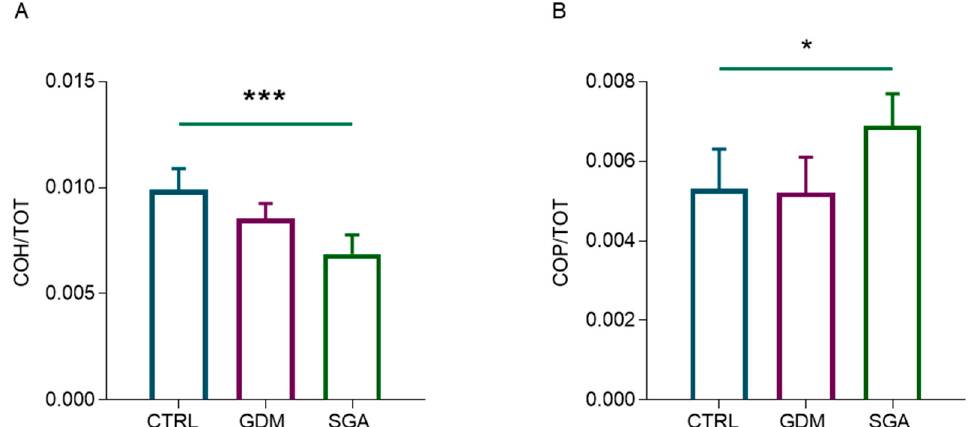
Figure 9. FTIRI analysis of glycosylated compounds and phosphodiester bonds in CV sections of CTRL, GDM, and SGA experimental groups. Statistical analysis of the following band area ratio: ( A ) COH/TOT (representing the relative number of glycosylated compounds) and ( B ) COP/TOT (representing the phosphodiester bonds). Results are reported as mean ± SD of five independent samples ( n = 5), and asterisks indicate significant differences between CTRL and SGA groups (* = p < 0.05 and *** = p < 0.001). CTRL: control group (blue), GDM: gestational diabetes mellitus (purple), SGA: small-for-gestational-age (green).